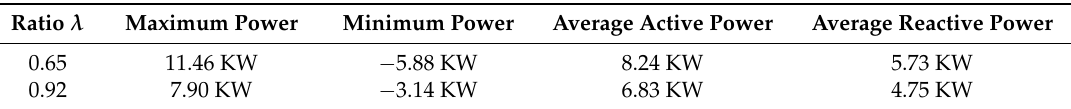
Table 3. Balance ratio and the corresponding motor power parameters under two different balance states of the No. M45 beam pumping